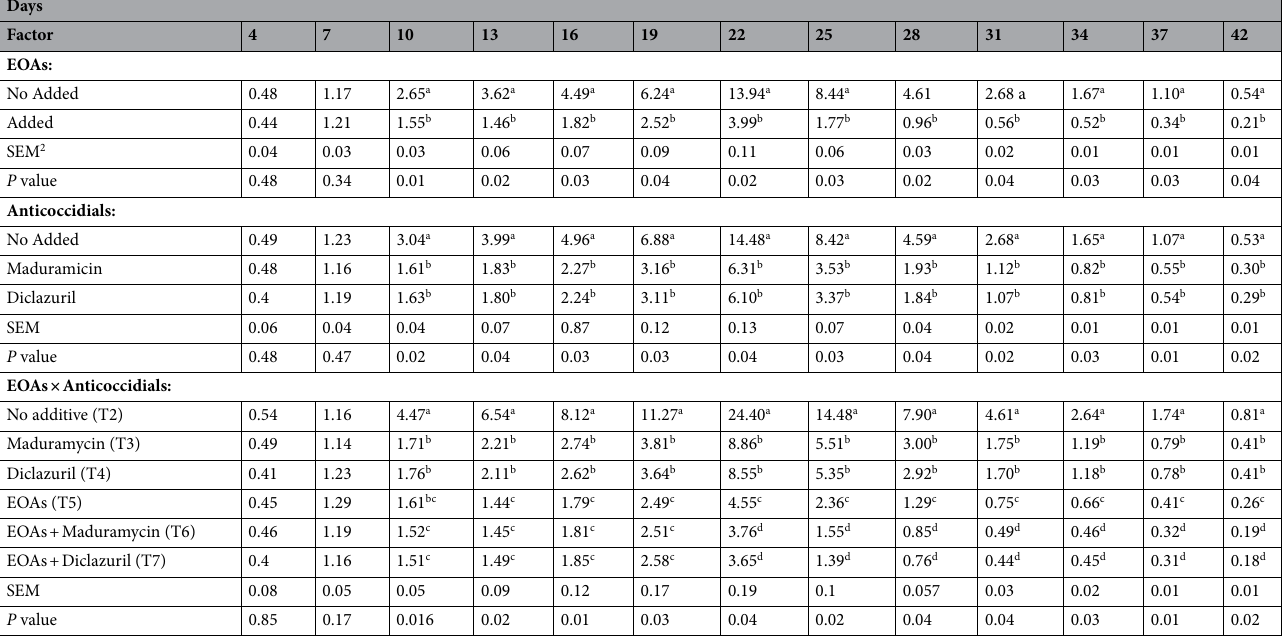
Table 3. Effect of EOAs and anticoccidials on OPG 1 in broilers infected with Eimeria (× 1000). a- b In each column, means with no same (a, b) superscript differ significantly in p < 0.05 value. 1 OPG: Oocyst output per gram feces; 2 Pooled standard error of